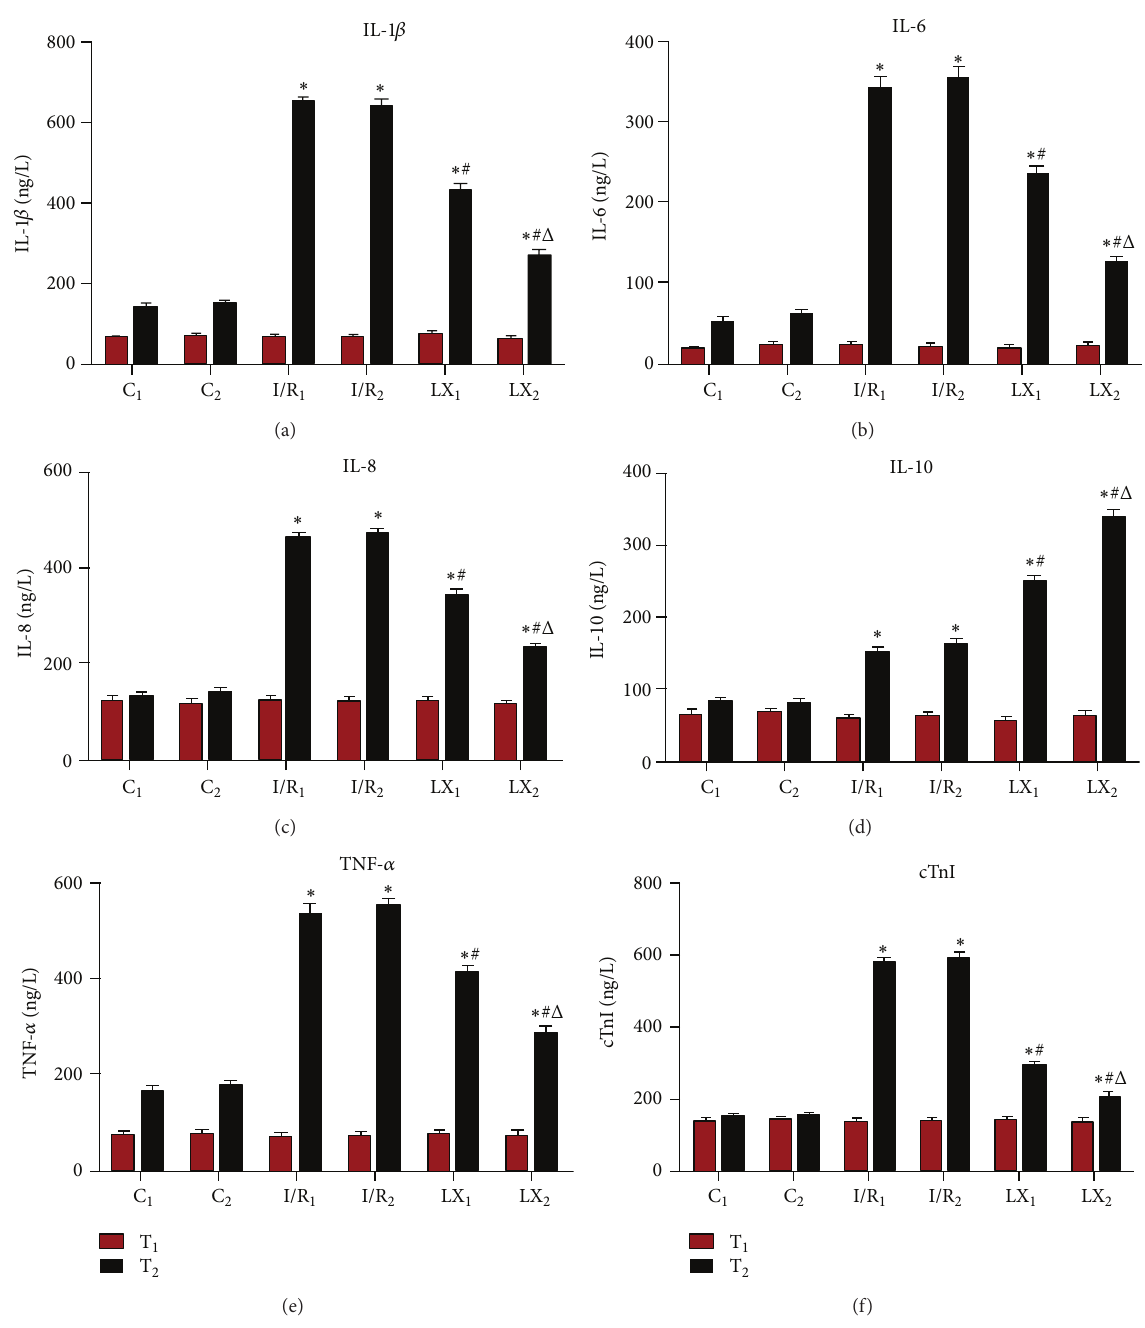
Figure 1: Comparison of concentrations of serum IL-1 𝛽 , IL-6, IL-8, IL-10; TNF- 𝛼 ;, and cTnI at T 1 and T 2 among all groups ( 𝑛 = 12 for each group). At time point T 1 , blood was collected immediately before thoracotomy. At time point T 2 , blood was collected right after the I/R procedure was over. (a) IL-1 𝛽 ; (b) IL-6; (c) IL-8; (d) IL-10; (e) TNF- 𝛼 ; (f) cTnI. ∗ 𝑃 < 0.05 for comparisons of I/R 1 and LX 1 groups with C 1 group, 𝑃 < 0.05 for comparisons of I/R 2 and LX 2 with C 2 group; # 𝑃 < 0.05 for comparisons of LX 1 group with I/R 1 group, 𝑃 < 0.05